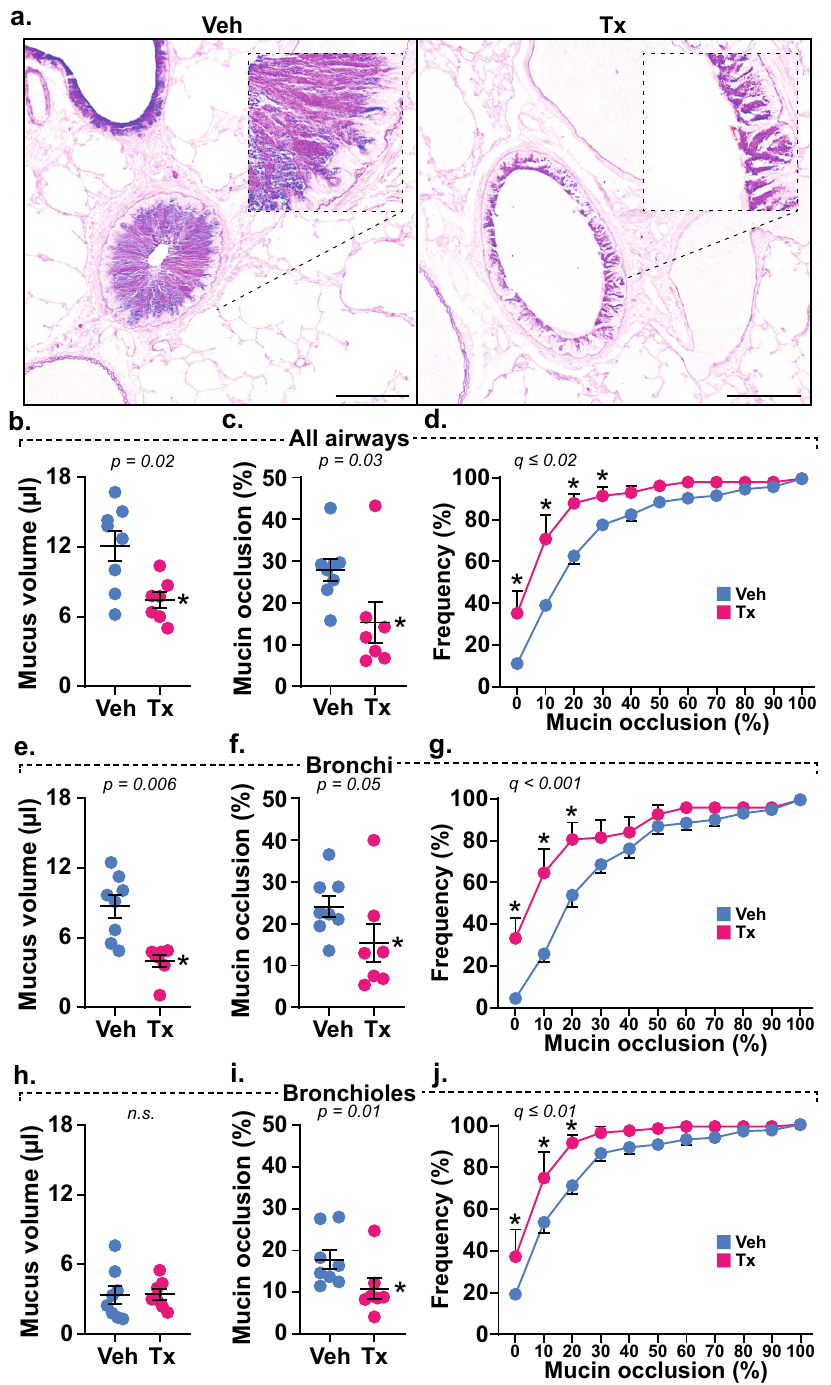
Fig. 4 Mucolytic treatment disrupts mucus plugging. a AB-PAS stained lungs obtained after methacholine dose response tests show mucin glycoproteins obstructing airspaces in vehicle (Veh, n = 8 biological replicates) treated mice that are disrupted by mucolytic treatment (Tx, n = 7 biological replicates). Scale bars, 500 μ m (low power) and 25 μ m (high power). b – j Calculated mucus volumes ( b , e , h ), mean fractional occlusion ( c , f , i ), and heterogeneous plugging ( d , g , j ) were signi fi cantly decreased in AOE-challenged mice receiving mucolytic (Tx, magenta, n = 7 biological replicates) compared to controls (Veh, cyan, n = 8 biological replicates). Mucolytic treatment signi fi cantly reduced obstruction across all airways ( b – d ), and this effect was most prevalent in bronchi ( e – g ). Although total mucus volume in bronchioles was low ( h ), occasional mucus aggregates were obstructive and are sensitive to TCEP treatment ( i , j ). Data in b , c , e , f , h , and i are means ± sem on scatter plots, with p -values shown and signi fi cance (*) indicating p < 0.05 by two-tailed Mann – Whitney U -test. Cumulative frequency distributions in d , g , and h show percentages of airways demonstrating occlusion, with circles and error bars identifying means ± sem, and “ * ” demonstrating signi fi cance by t -test using a two-stage step-up method at a 5% false discovery rate. Source data are provided as a Source Data fi